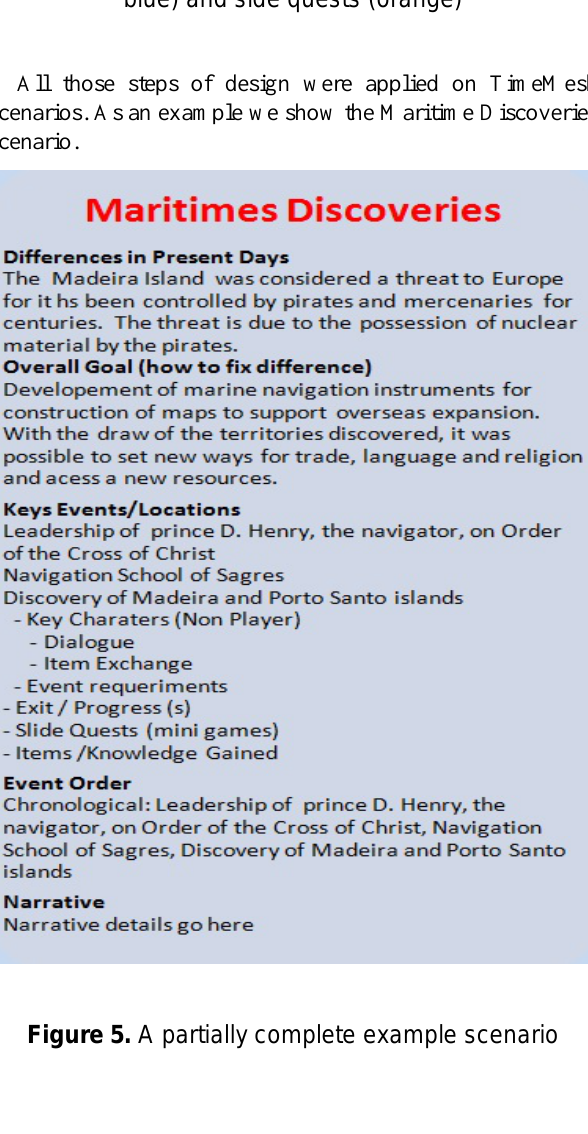
Figure 4. Plot points: required (blue), optional (light blue) and side quests (orange) All those steps of design were applied on TimeMesh scenarios. As an example we show the Maritime Discoveries scenario.